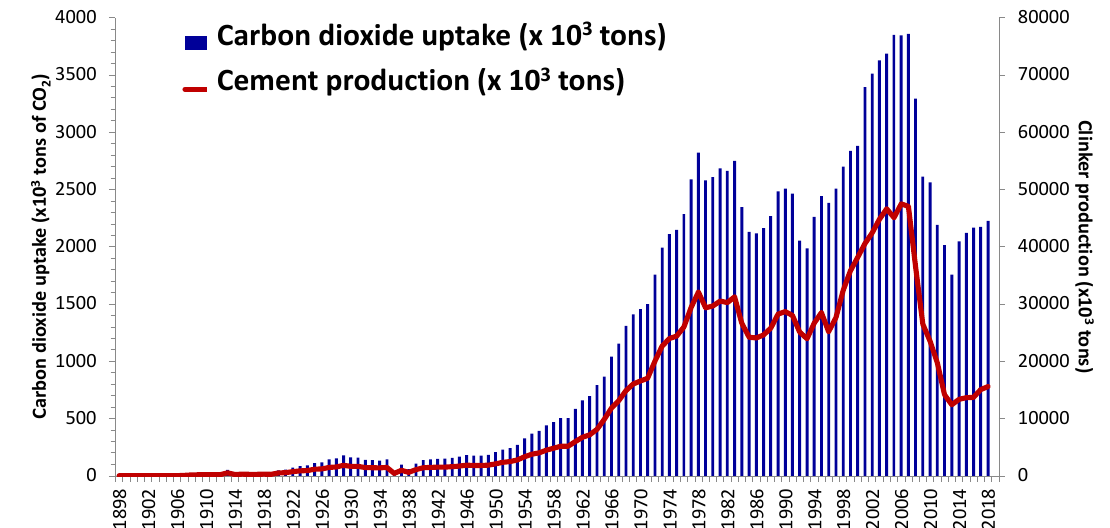
Figure 9. Portland cement production and estimated carbon dioxide uptake by using the Tier 1 approach [13] in Spain from 1898 to 2018 (120 years).